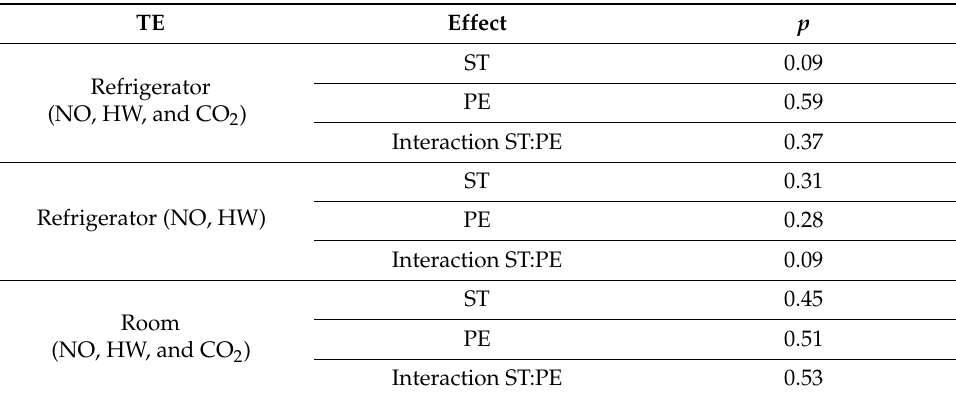
Table 6. Fixed temperature—two-way ANOVA *.